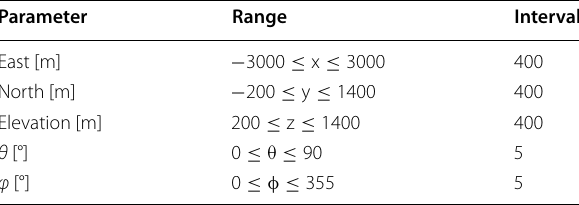
Table 1 Grid search ranges and intervals for the